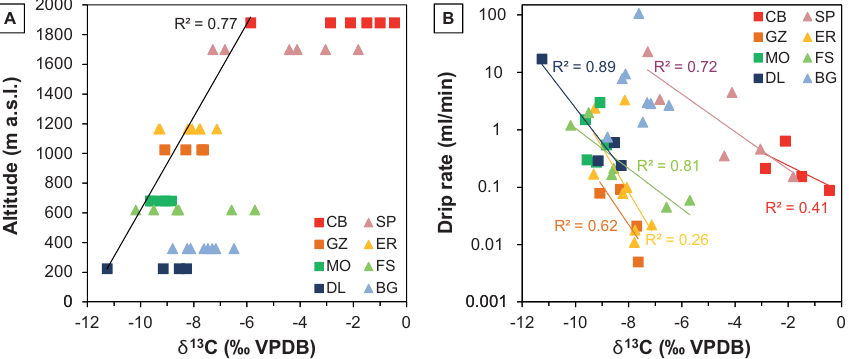
Fig. 9. Calcite carbon isotope values against (A) the altitude of the cave entrance and (B) drip rate. In (A) , the trend lines have been calculated using just the least modified calcite precipitates from each cave site (see Fig. 5). In (B) , exponential trends (note log scale) are shown for individual cave